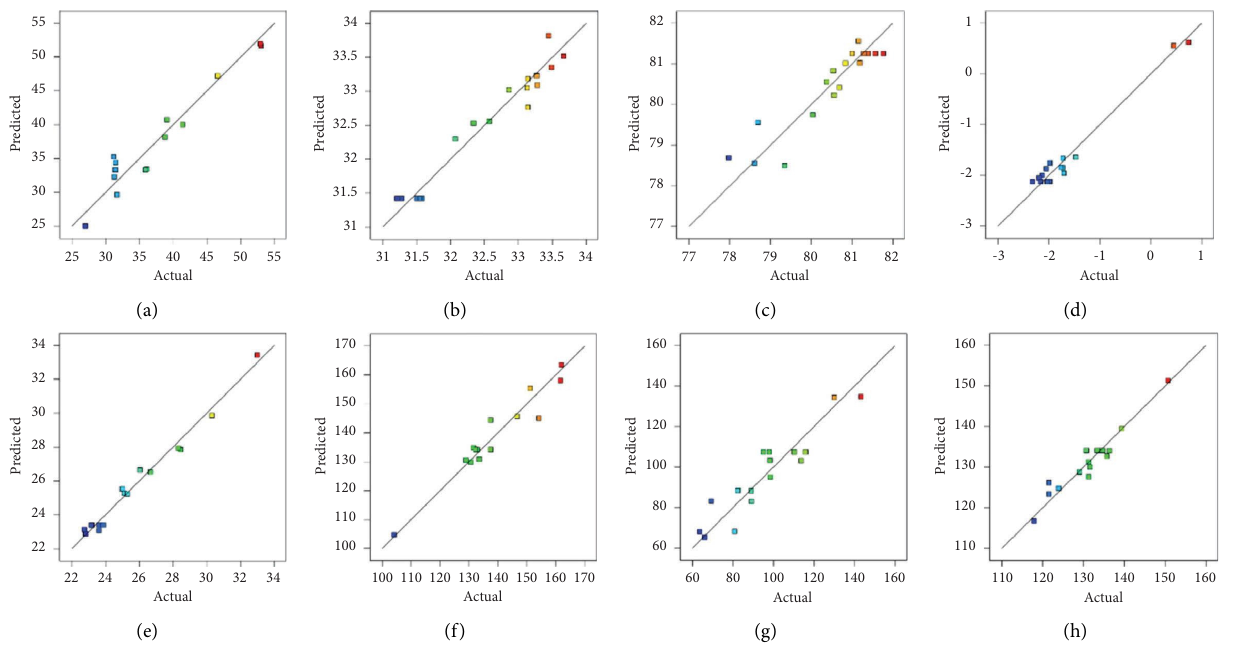
Figure 4: Correlation between predicted and actual values for (a) weight loss (g/kg); (b) frmness (N); (c) L ∗ value; (d) a ∗ value; (e) b ∗ value; (f) total phenolic content (mg/kg); (g) ascorbic acid (mg/kg); and (h) total antioxidant capacity (mg/kg) of beeswax